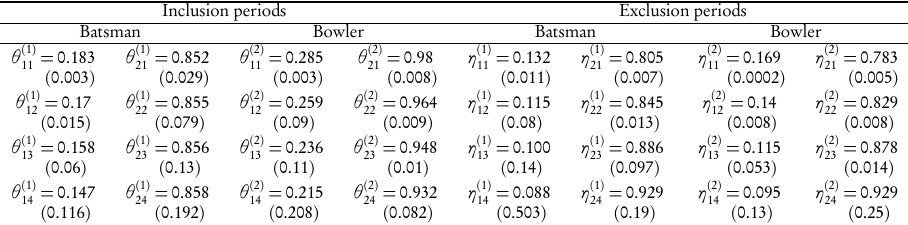
( k ) ( k ) , k = 1,2; l = 1,2; j = 1,2,3,4 and η l j l j